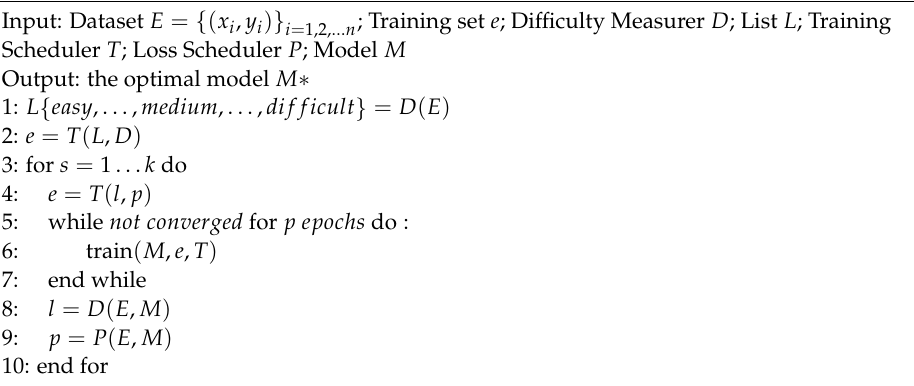
Algorithm 1: Curriculum Learning